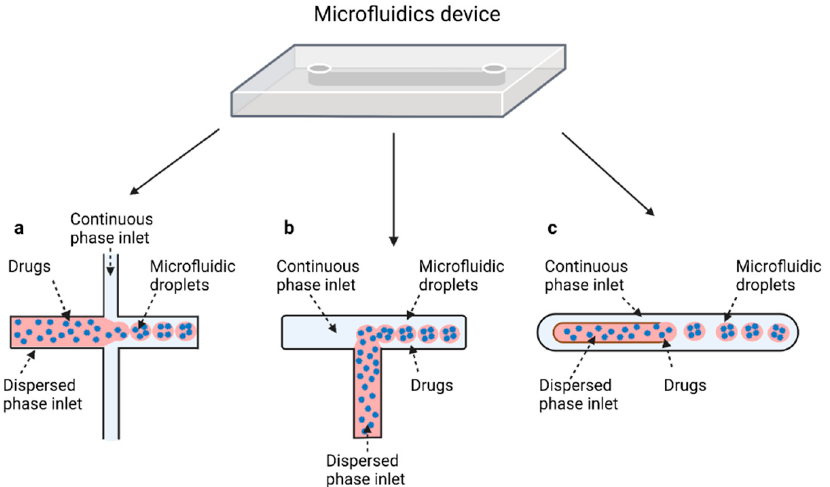
Figure 2. Schematic illustration of the most common designs used to make droplets with microfluidic devices. Flow-focusing ( a ): the two phases meet at the junction where the continuous phase pinches off droplets of the dispersed phase from the bottom and the top. T-junction ( b ), where both phases meet at a T-shaped junction and the shear stress created by the continuous phase causes droplet formation. ( c ) Droplet formation using a coaxial geometry, where the continuous phases completely surround the dispersed phase in three dimensions to create droplets. Created with BioRender.com (accessed on 24 December 2021).